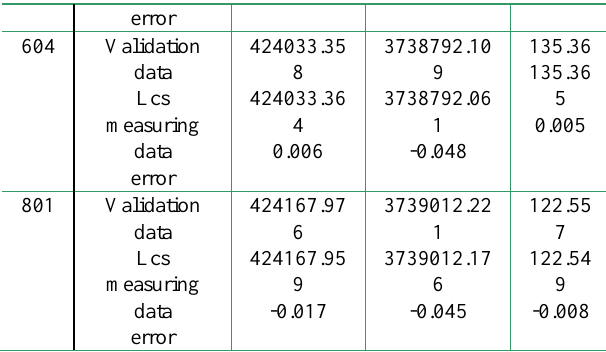
Table 1. checkpoint precision table (unit: m)